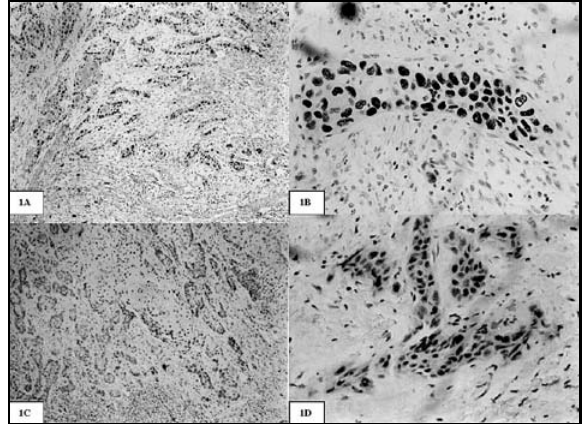
Figura – A: imunolocalização da proteína p53; B: em detalhe, células p53 positivas na região do front de invasão; C: imunolocalização da proteína p16 D-. No detalhe, células p16 positivas na região do front de invasão. Notar maior imunolocalização da p53 nas áreas mais invasivas, ao contrário da encontrada para a proteína